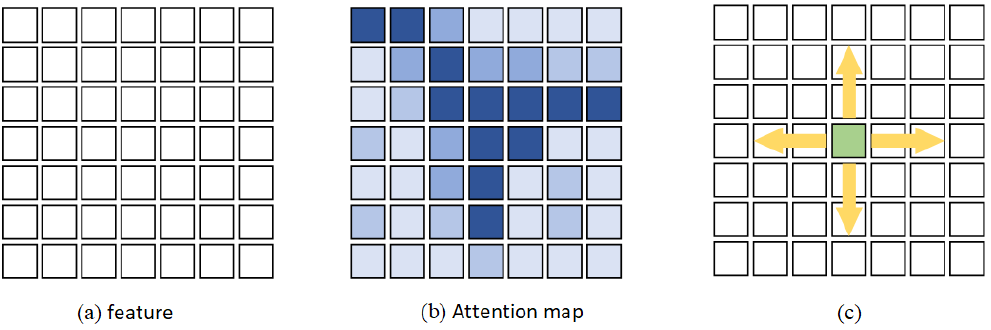
Figure 2. ( a ): The image input features; ( b ) the relevance of each point after visualization; ( c ) the value of the green point depends on the information about the known surrounding